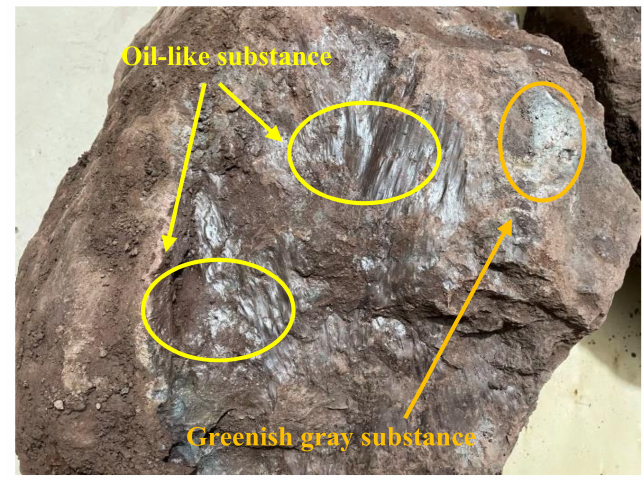
Figure 1. Excavated natural mudstone.